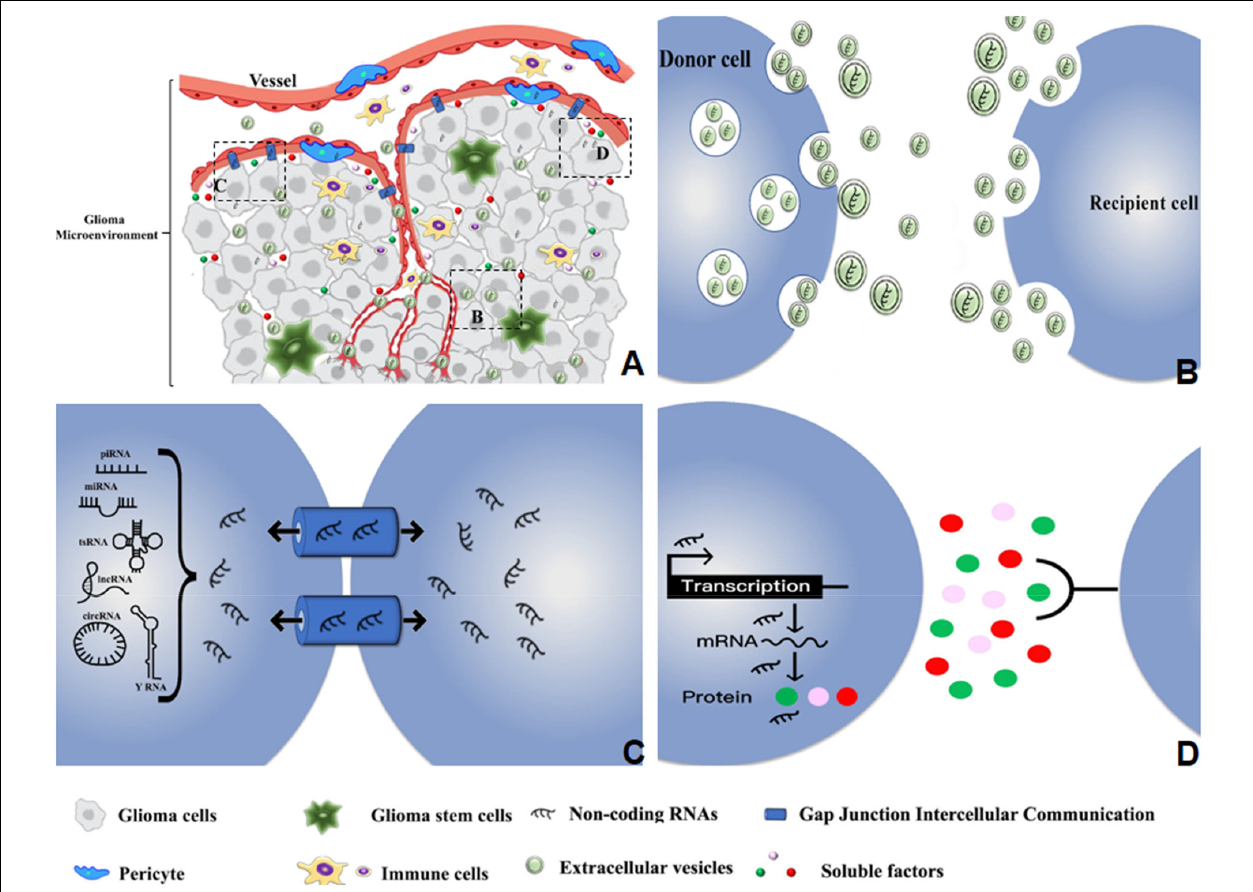
FIGURE 1 | Diverse types of intercellular communications mediate the regulatory effects of ncRNAs on glioma angiogenesis in the tumor microenvironment. (A) The distribution and delivery of ncRNAs within the glioma microenvironment. (B) Delivery of ncRNAs from donor to recipient cells through the small EVs and medium/large EVs. (C) Transmission of ncRNAs between adjacent cells through GJIC based on gap junctions and channels. (D) ncRNA regulation of soluble factors that mediate the interaction between donor and recipient